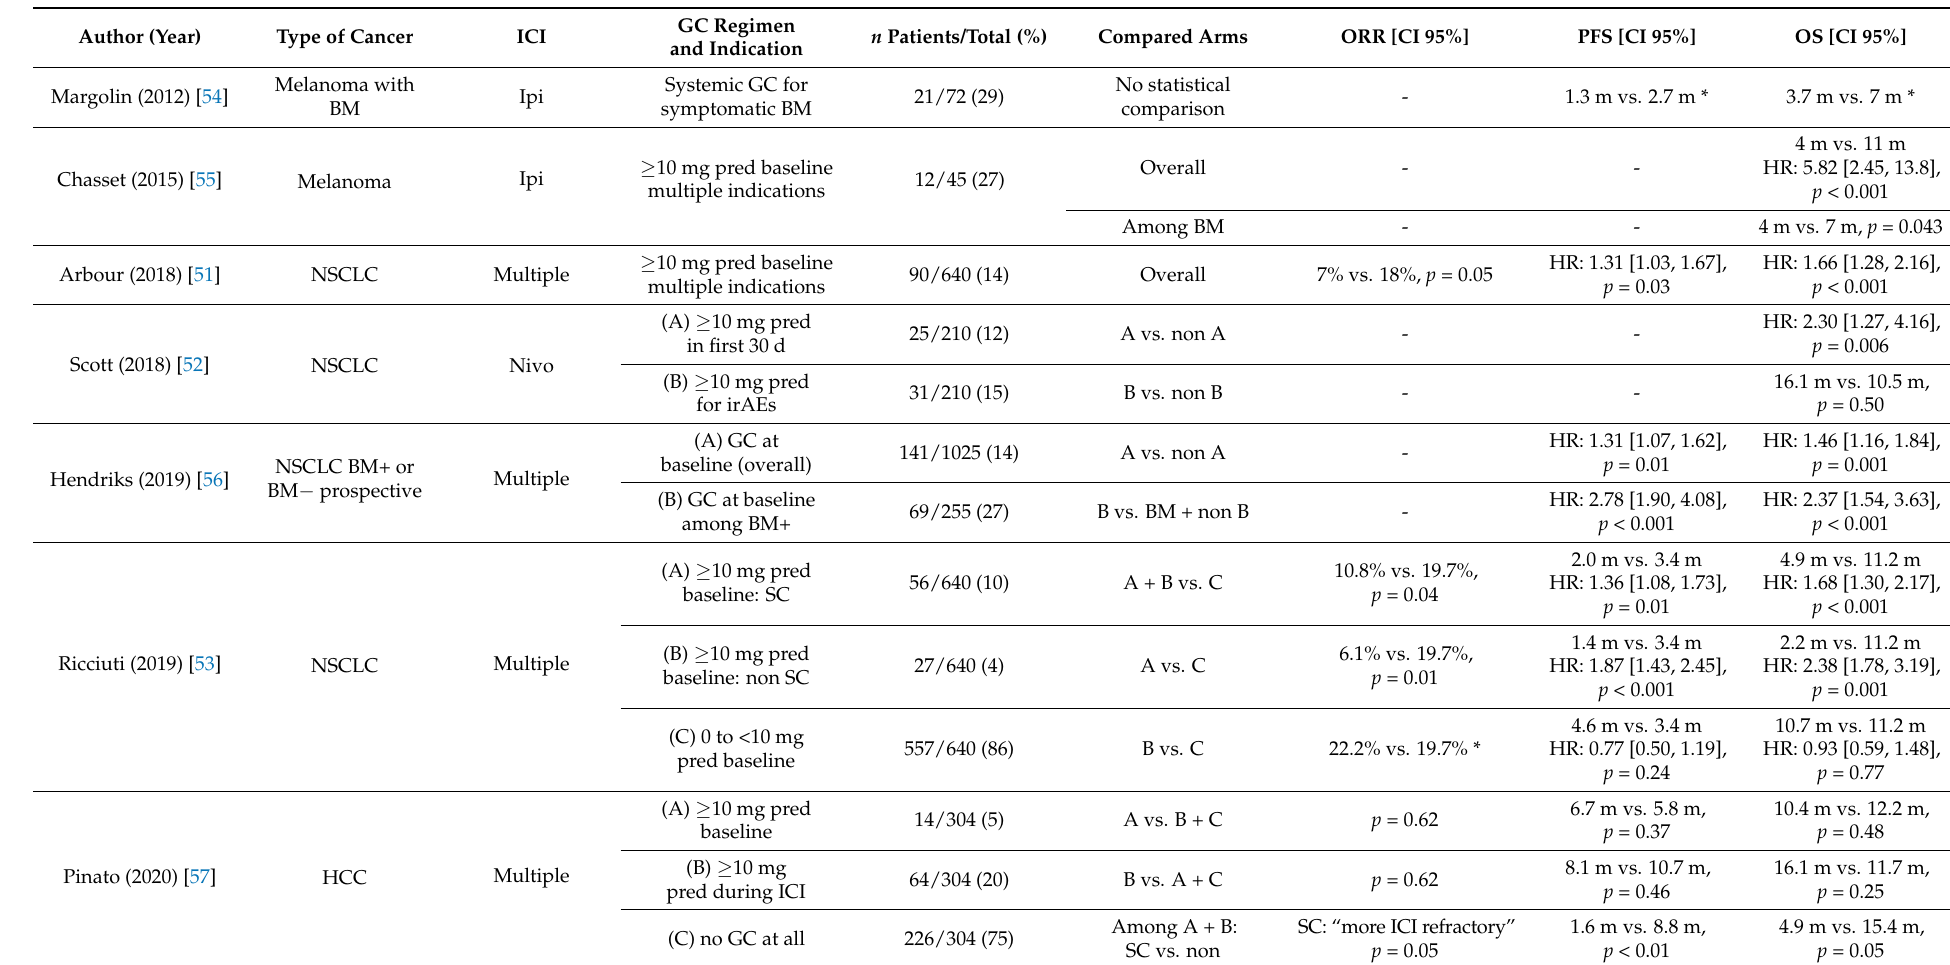
Table 1. Studies analyzing the impact of baseline or concomitant corticosteroids with ICI treatment on response rate and survival